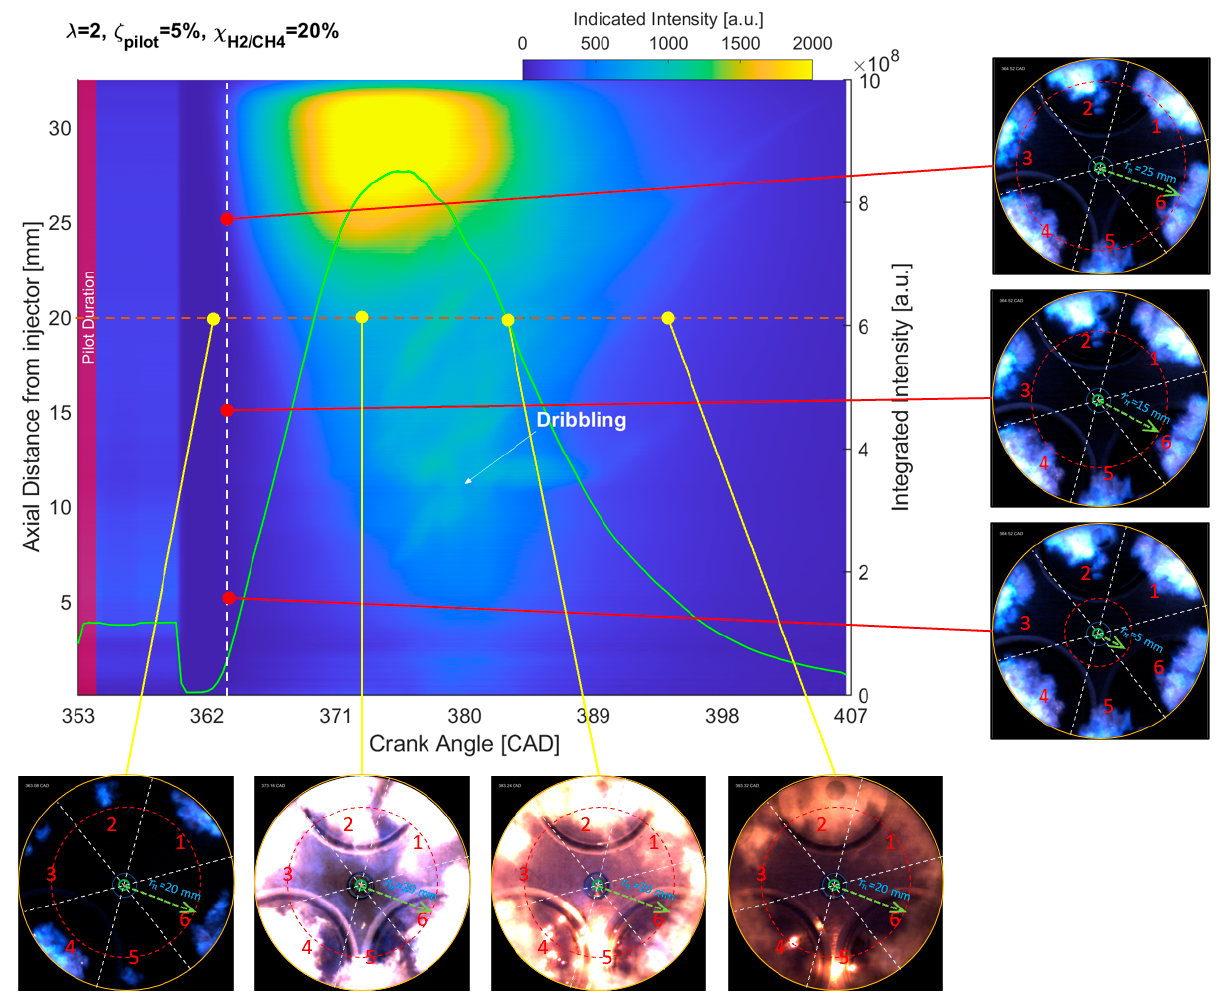
Figure 4. Equation (1) defines the spatiotemporal intensity I ( r n , CAD ) , which represents